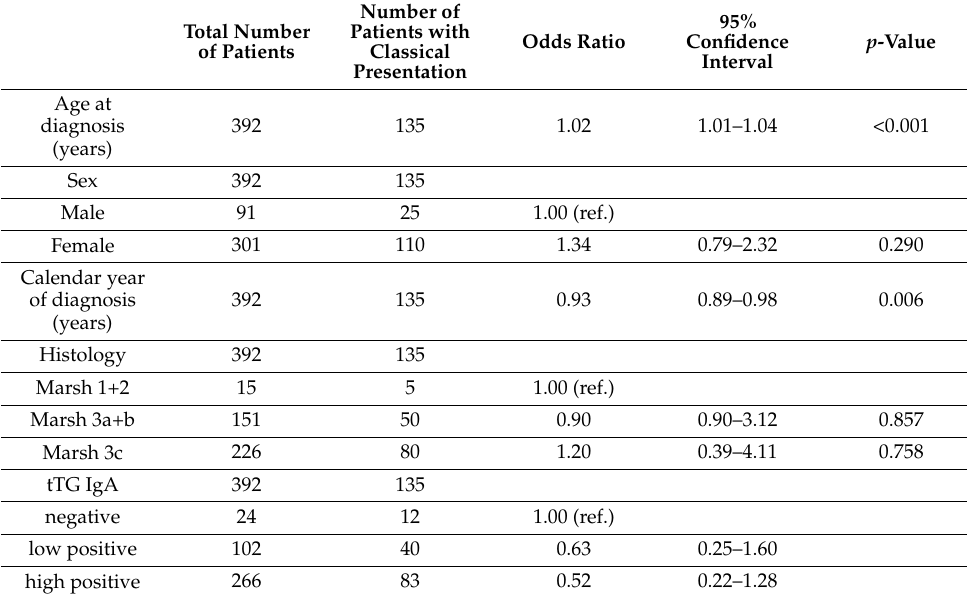
Table 2. Associations between baseline parameters and clinical presentation of celiac disease (multi- variate logistic regression